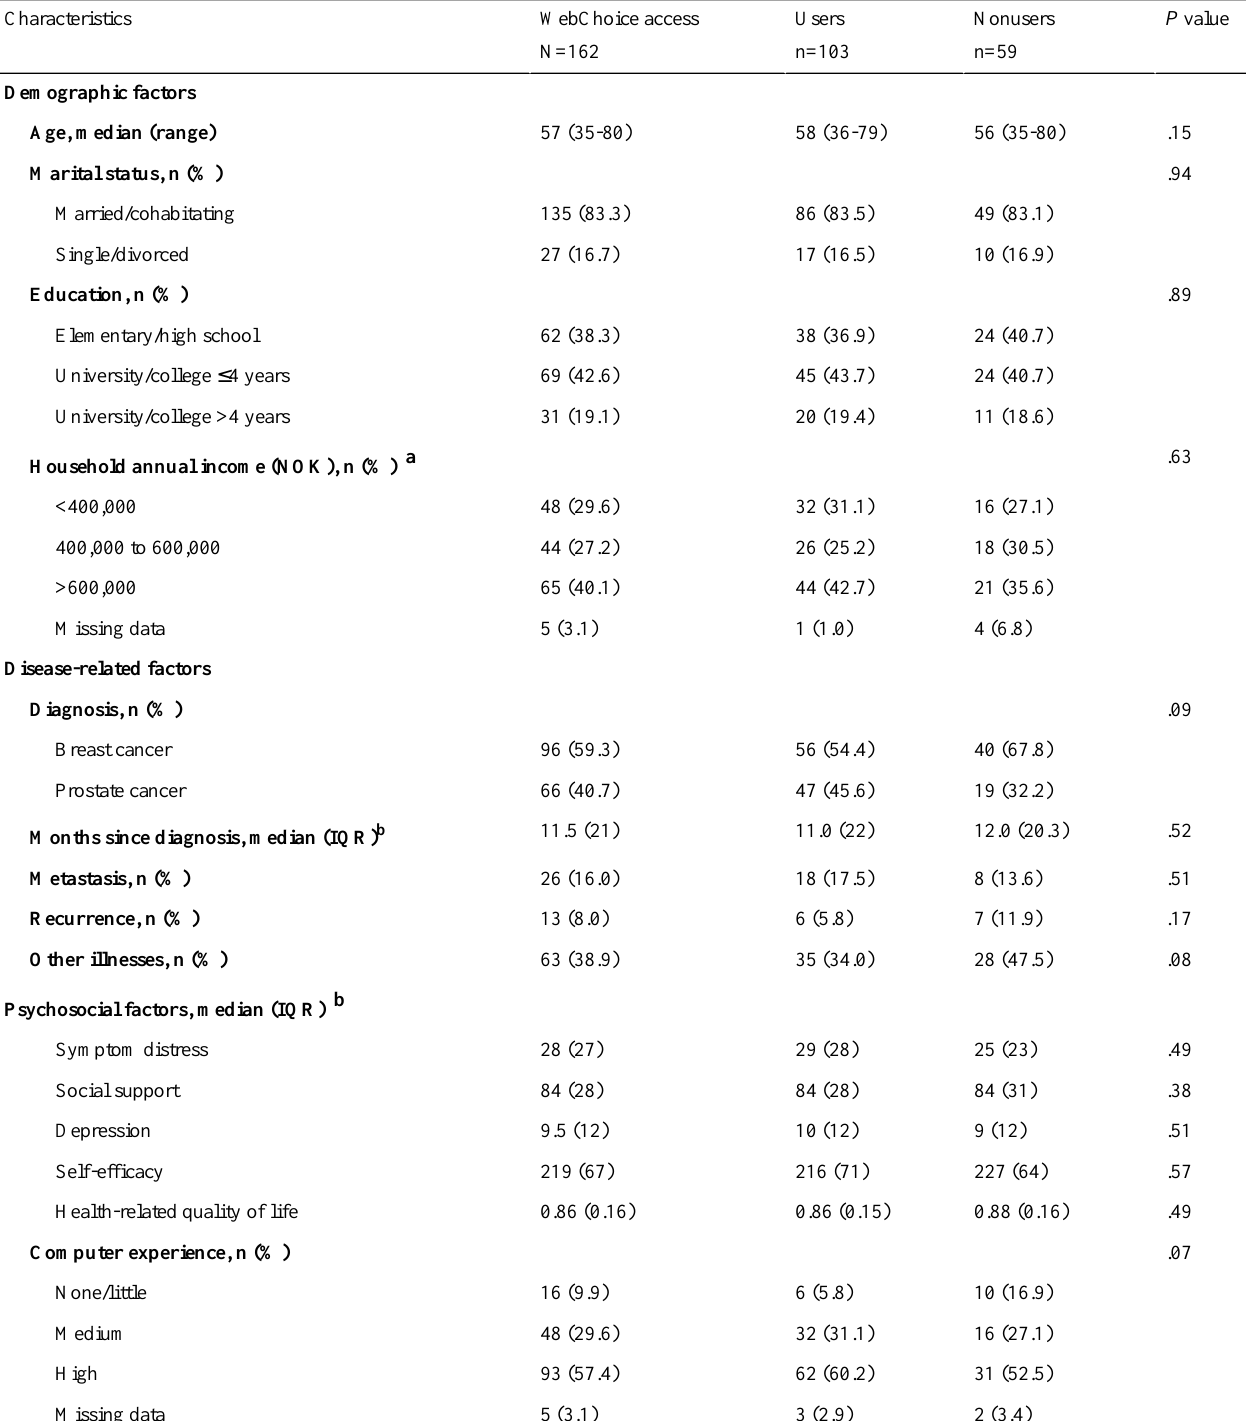
Table 2. Characteristics of all breast and prostate cancer patients (users and nonusers) with access to